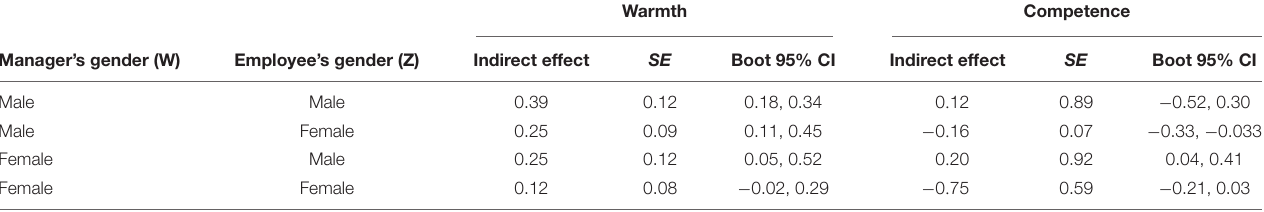
TABLE 4 | Conditional indirect effects of humor on behavioral intentions via IM as a function of manager’s gender (W) and employee’s gender (Z).